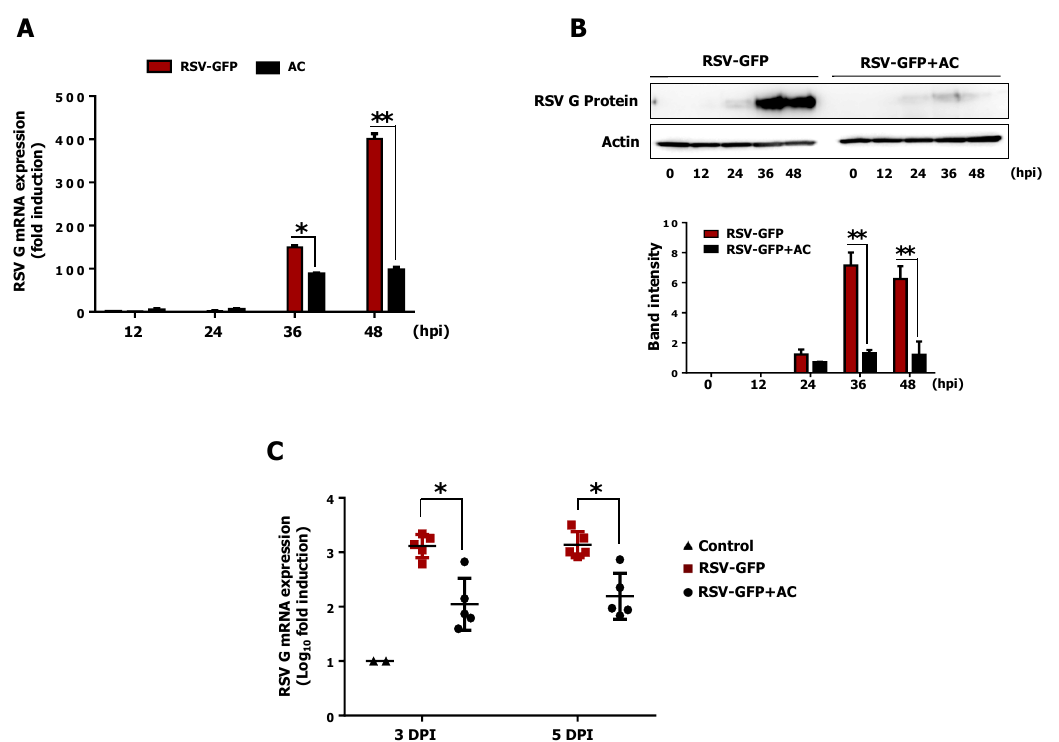
Figure 6. Antiviral e ff ect of acteoside in-vitro and in-vivo . ( A ) RSV-GFP infected cells were treated with 50 ng / mL of AC at 2 hpi and cells were harvested at indicated time points. RSV-G protein mRNA transcription level was determined by qRT-PCR. GAPDH was used for normalization. ( B ) Infected cells were treated with 50 ng / mL concentration of AC at 2 hpi and cells were harvested at indicated time points. RSV-G protein expression was determined by immunoblotting with anti-RSV-G protein antibody, and the intensity of the RSV-G was quantified. ( C ) Five weeks old (16 g / mice) BALB / c mice ( n = 5) were intranasally infected with RSV-GFP (1 × 10 6 PFU / mice) in the total volume of 28 µ L. 6 hpi AC was intraperitoneally administrated at a dose of 80 mg / Kg body weight of mice. At 3 and 5 dpi, lung tissues were collected, and the transcription level of RSV-G protein mRNA was determined by qRT-PCR. mRNA expression and band intensity expressed as mean ± SD. Error bars indicate the range of values obtained from three independent experiments. In vivo experiment was performed in duplicate. (* p < 0.05 and ** p < 0.01 regarded as significant di ff